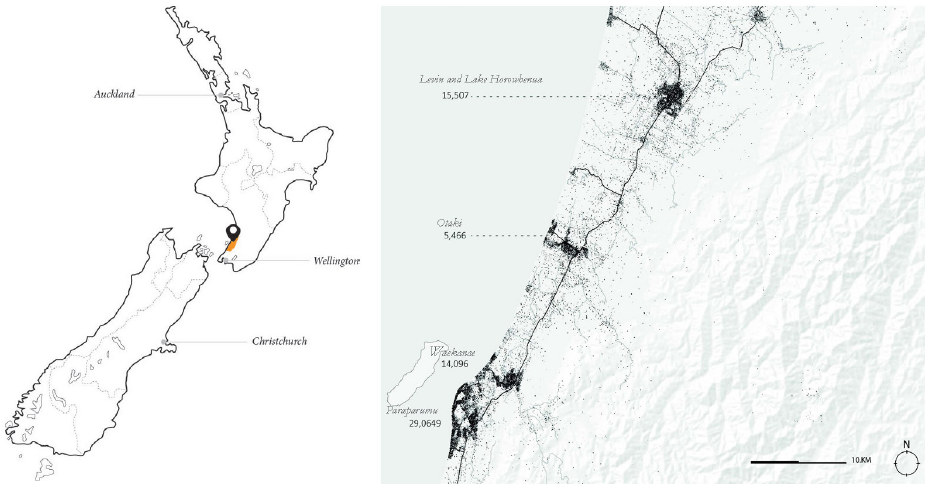
Figure 1. Map of New Zealand. Kapiti Horowhenua is located above Wellington (left) Source: Nick Wheaton . Existing settlement in Kapiti Horowhenua. Numbers denote population in 2014 (right). Source: Winston Dewhirst .